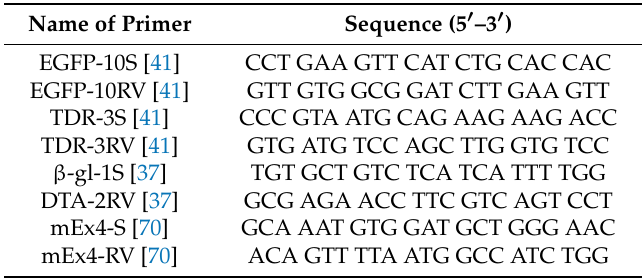
Table 1. Nucleotide sequences of primers used in this